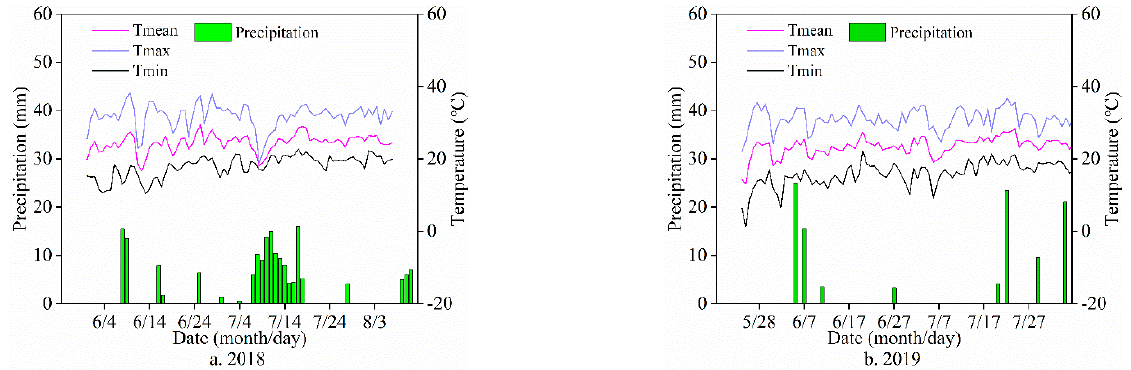
Figure 1. Daily maximum and minimum temperatures, average temperatures and precipitation in experimental site throughout the waxy maize growing seasons. ( a ) The data in 2018; ( b ) The data in 2019.